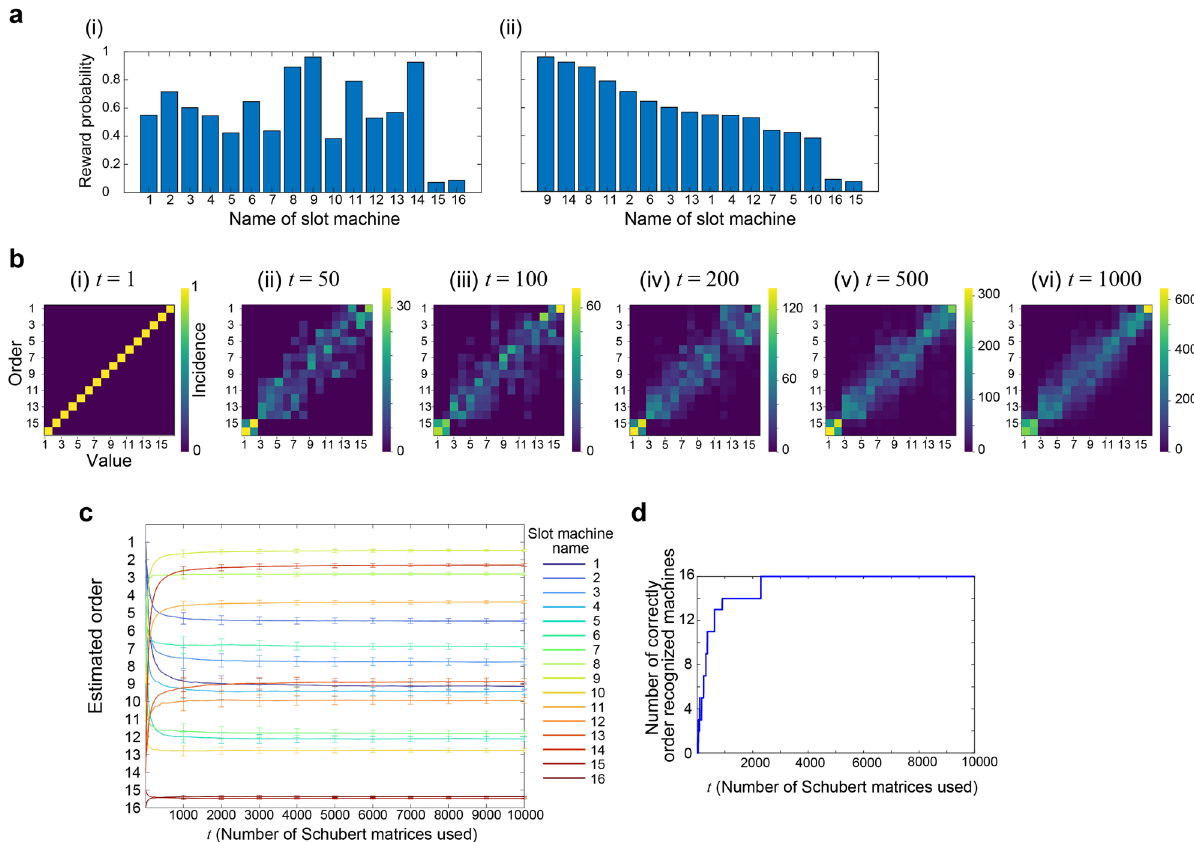
Figure 5. Demonstration of order recognition in 16 slot machine environments. ( a ) (i) Reward probability arrangement and (ii) its sorted representation. ( b ) The accumulated incidence pattern of the ranking-and-value matrix after the loop of (i) 1, (ii) 50, (iii) 100, (iv) 200, (v) 500, and (vi) 1000. ( c ) The time evolution of the estimated ranking of each slot machine. ( d ) The number of correctly ordered machines over